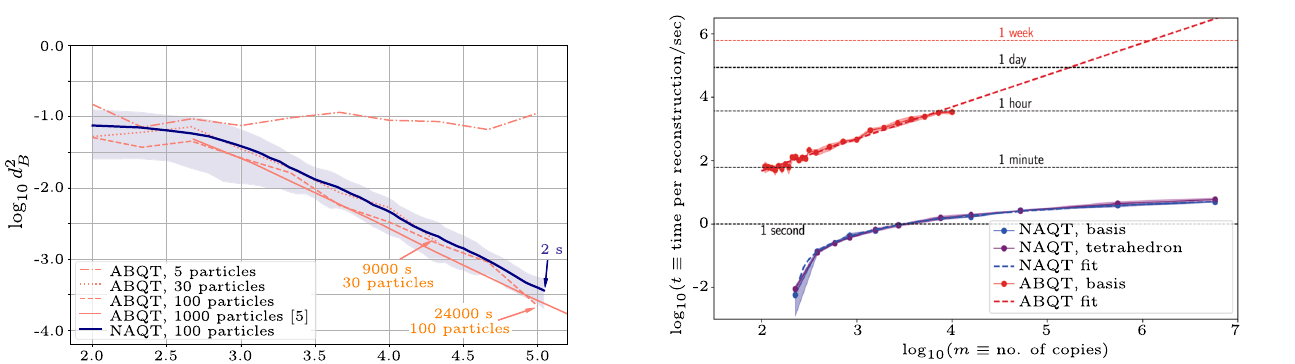
Fig. 3 Scaling of reconstruction runtime with the number of copies measured, using the basis POVM, as well as the product tetrahedron POVM (for NAQT; see main text), all with 100 particles. The runtime curves are fi tted to the following lines: for NAQT, t = − 3.5s + (1.3s) log 10 ( m + 300); for ABQT, t = (0.4s) m . Com- parisons were run on the same computational hardware. For >10 5